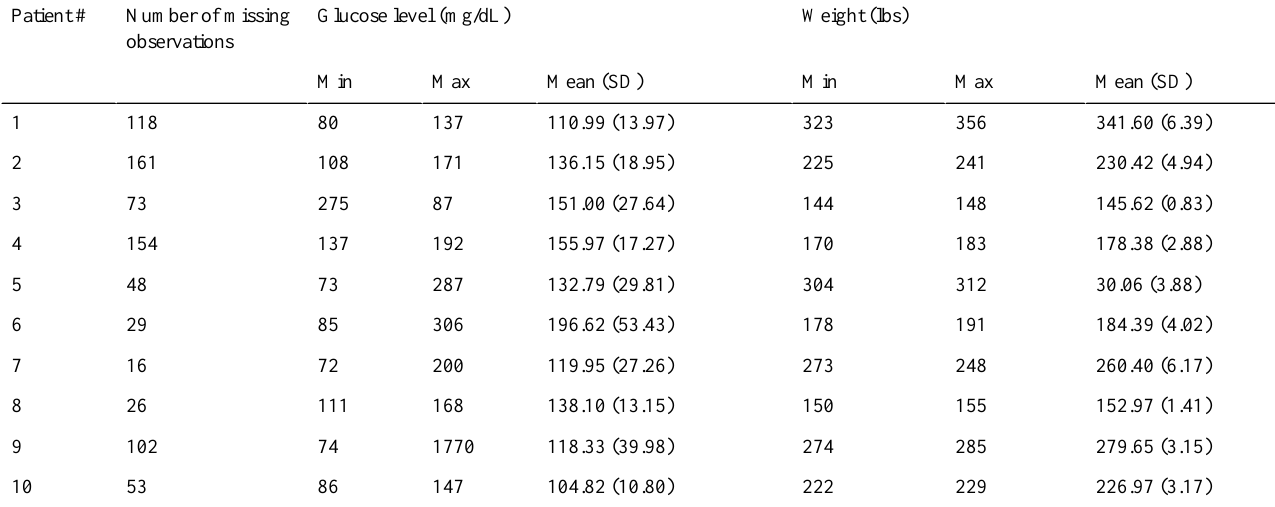
Table 1. Descriptive statistics of glucose and weight levels for the patients in the